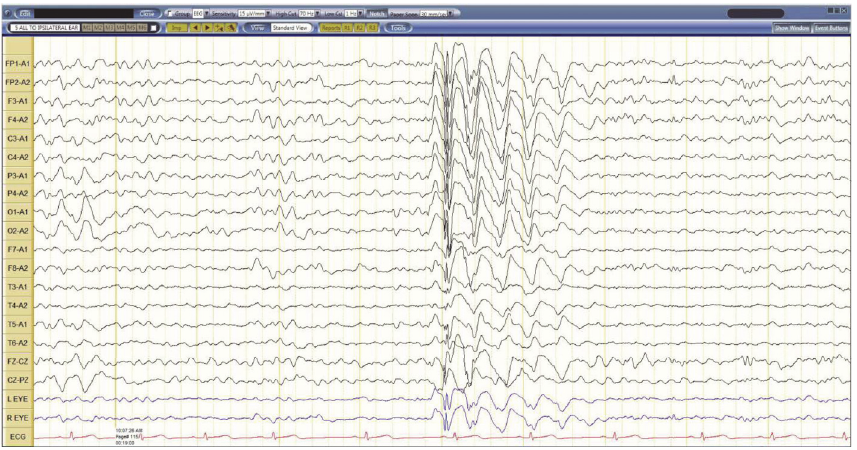
Figure 1: An interictal EEG sample showed 3Hz generalized spike-and-wave discharges using an ipsilateral ear referential montage (sensitivity 15 𝜇 V/mm; high frequency filter 70 Hz; low frequency filter 1Hz; paper speed 30